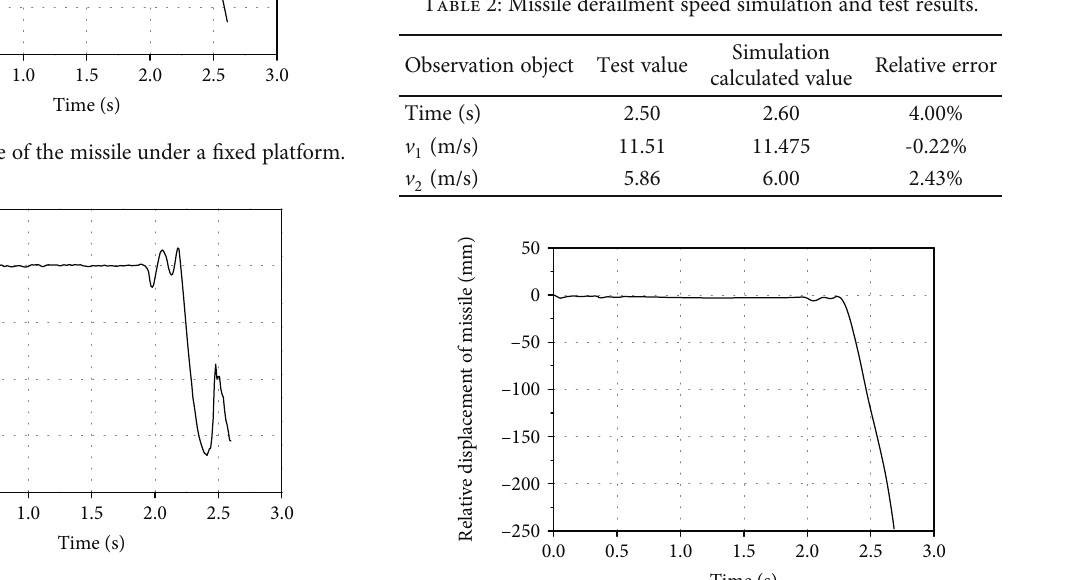
Figure 14: The pitch angular velocity of the missile under a fi xed